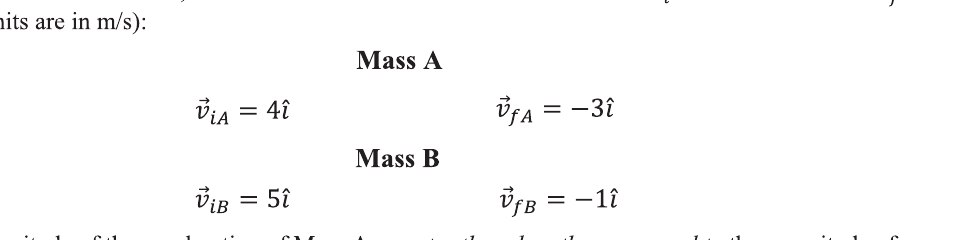
SE.FIG. 7. Examples of one-dimensional physics context questions in arrow and ijk